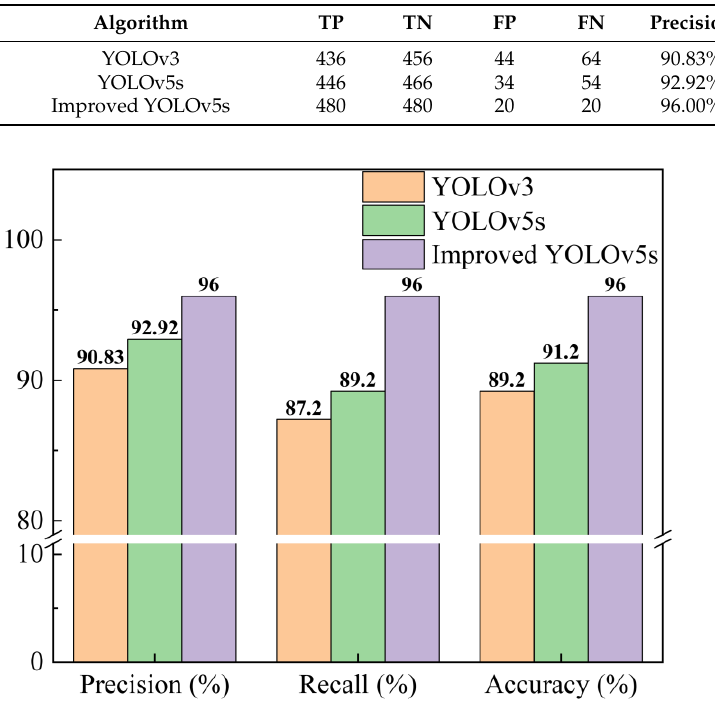
Figure 13. Comparison of sorting results of YOLOv3, YOLOv5s, and improved YOLOv5s models.